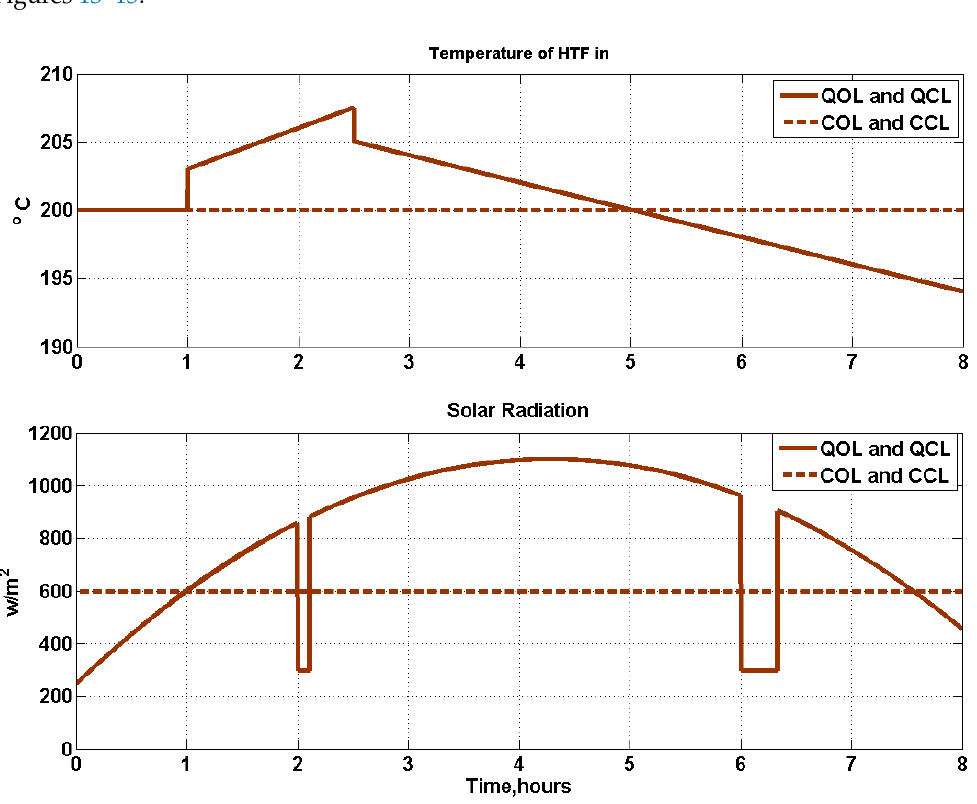
Figure 8. ( a ) Temperature of therminol oil/molten salt flowing in towards PTC; ( b ) solar radiation applied for case